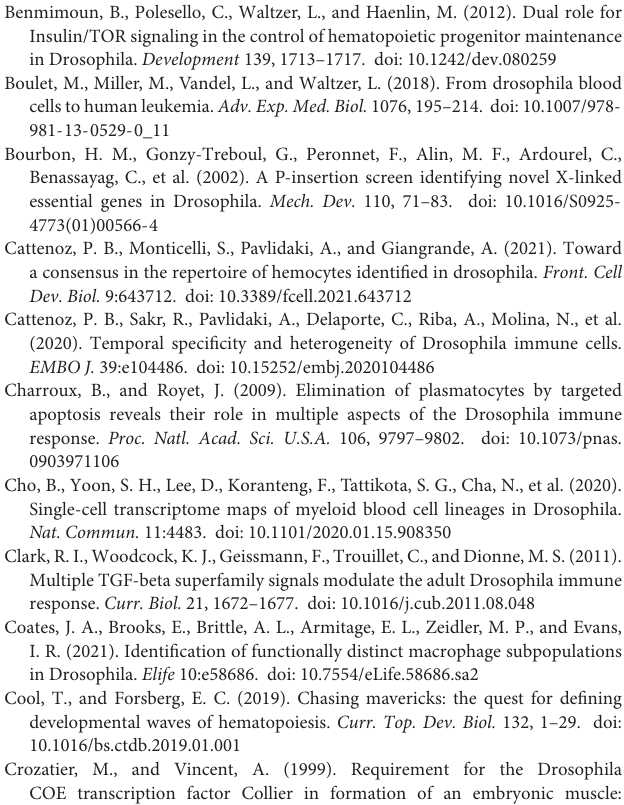
domeMeso > G-TRACE ). Supplementary Table 9 | Quantifications of round or fusiform hemocytes in G1, S or G2/M phase of the cell cycle in control or in E. coli -infected adult flies ( srp > FUCCI